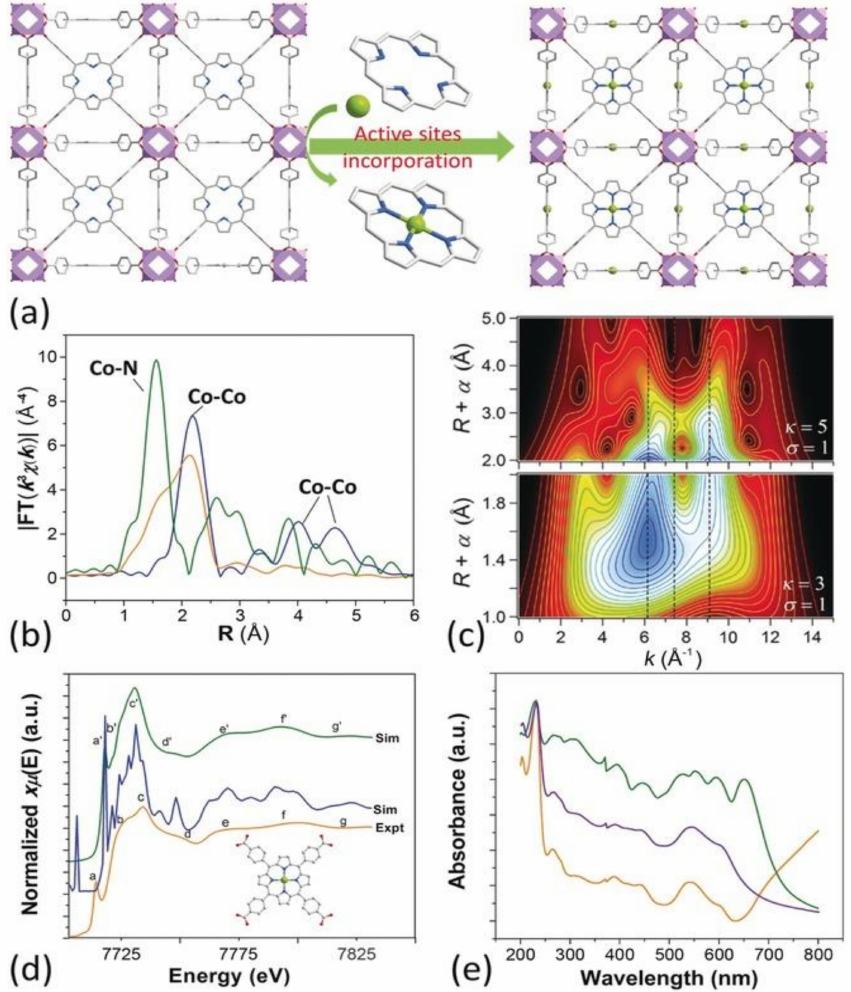
Figure 5. ( a ) View of the 3D network of MOF-525-Co featuring a highly porous framework and incorporated active sites. ( b ) Fourier transform magnitudes of the experimental Co K-edge EXAFS spectra of samples (not corrected for phase shift). Key: Co foil (blue), Co@C (orange), MOF-525-Co (green). ( c ) Wavelet transform for the k 3 -weighted EXAFS signal of MOF-525-Co, based on Morlet wavelets with optimum resolution at the first (lower panel) and higher (upper panel) coordination shells. Vertical dashed lines denoting the k-space positions of the Co-N and Co-Co contributions are provided to guide the eye. ( d ) Comparison between the Co K-edge XANES experimental spectrum (orange) of MOF-525-Co and the theoretical spectrum calculated with the depicted structure. For clarity, the non-convoluted theoretical spectrum is also shown. The energy-dependent exchange– correlation potential was calculated in the real Hedin–Lundqvist scheme, and then the spectra are convoluted using a Lorentzian function with an energy-dependent width to account for the broadening due both to the core–hole width and to the final state width. ( e ) UV/Vis spectra of MOF-525 (green), MOF-525-Co (purple), and MOF-525-Zn (orange). Reprinted with permission from Ref. [101]. Copyright 2016,